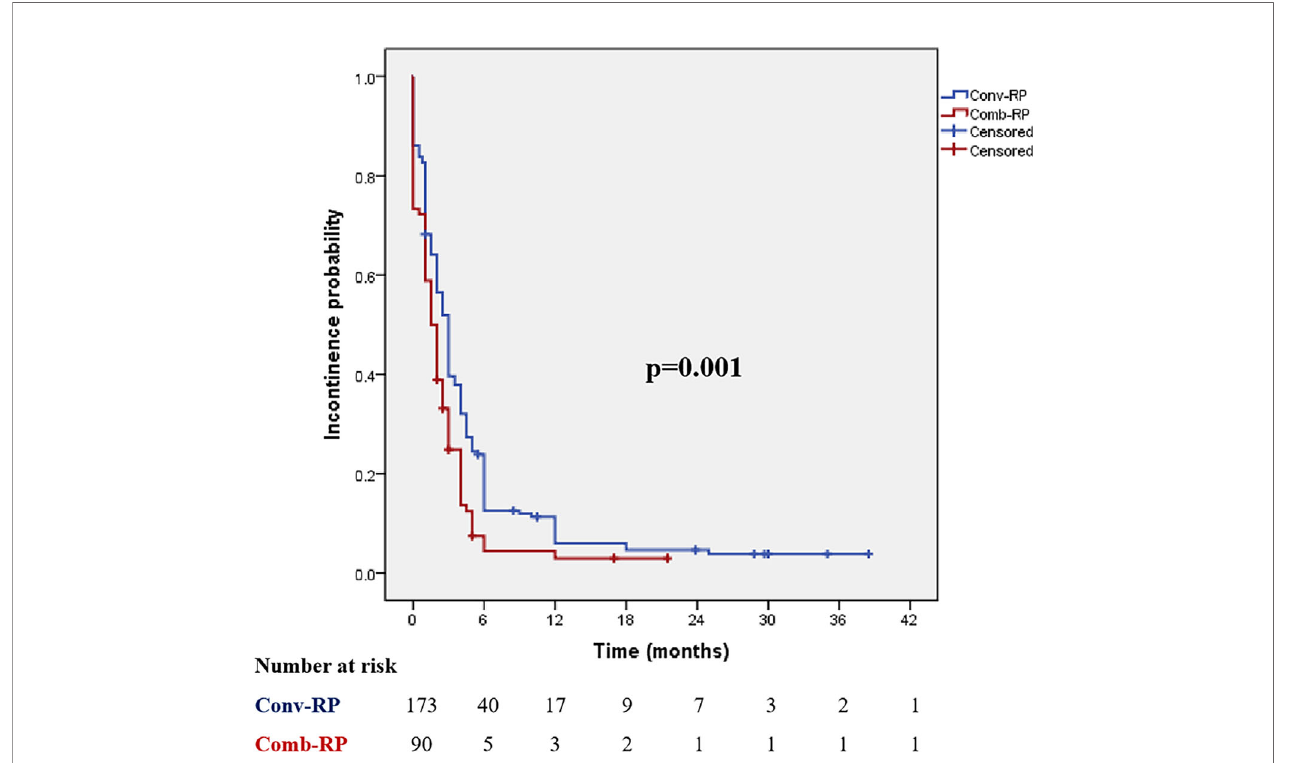
FIGURE 2 | Cumulative probability of incontinence after radical prostatectomy by study groups (Comb-RP and conv-RP). Conv-RP, conventional radical prostatectomy; Comb-RP, combined radical prostatectomy. Log Rank p =